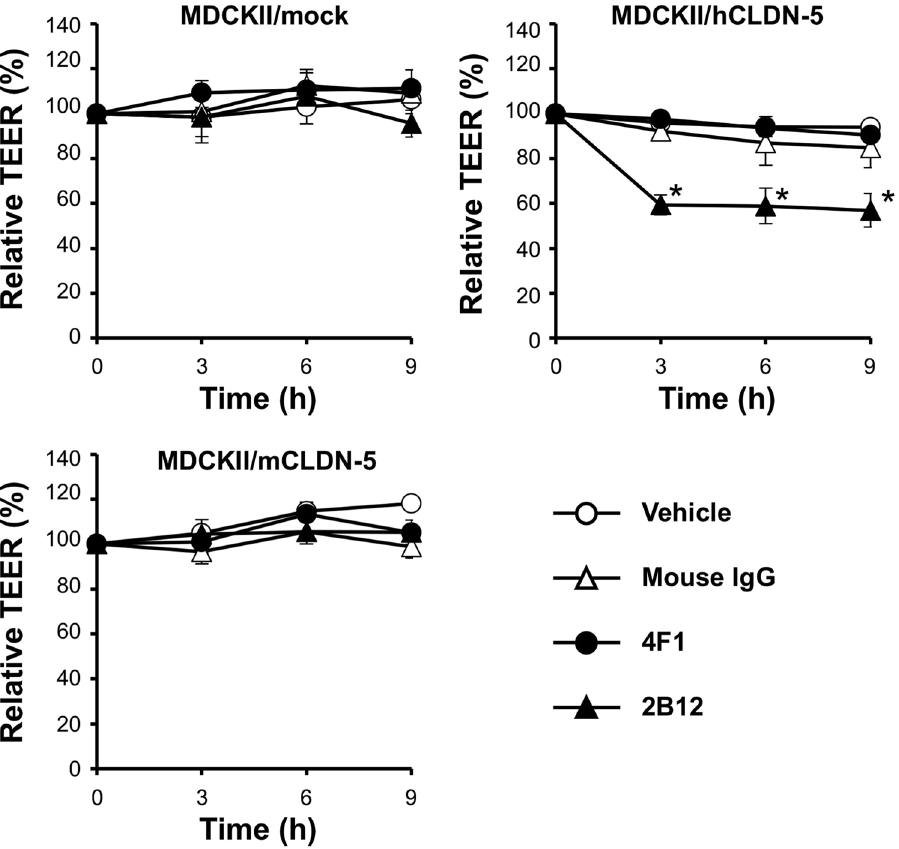
Figure 7. Effect of anti-CLDN-5 ECR mAbs on the paracellular barrier of CLDN-5–expressing cells monolayer. Monolayers of MDCKII expressing mock (upper left), human CLDN-5 (upper right) or mouse CLDN-5 (lower left) were basolaterally treated with vehicle (PBS) or 135 µ g/mL of antibodies (mouse IgG, 4F1 or 2B12) for 9 h. TEER was monitored throughout the treatment period. Relative TEER (%) to the value at 0 h is shown. Error bars represent standard error of the mean values (n = 3). * P < 0.05 versus vehicle